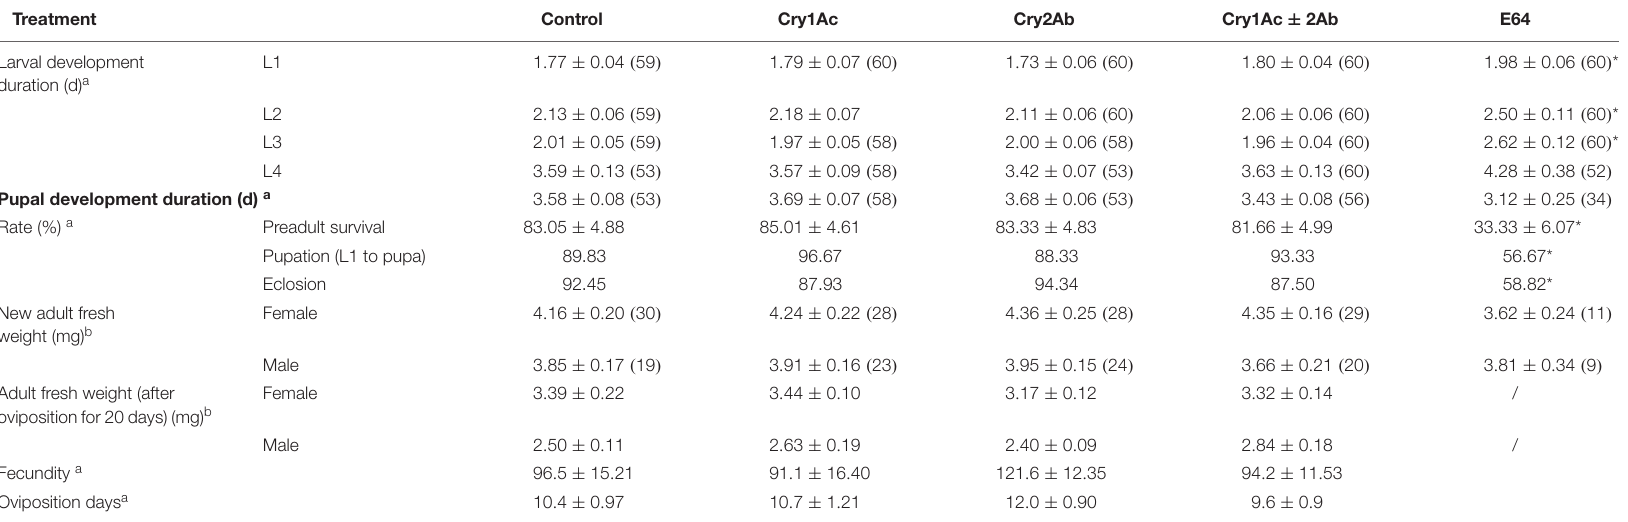
Data are the mean ± SE. An asterisk denotes a significant difference between a toxin treatment to control. Sixty larvae were tested for each treatment. Sample of adult dry weight in E-64 treatment was insufficient for data analysis. a: Bootstrap test. b: HSD test. “(n)” represents the number of P. japonica at early